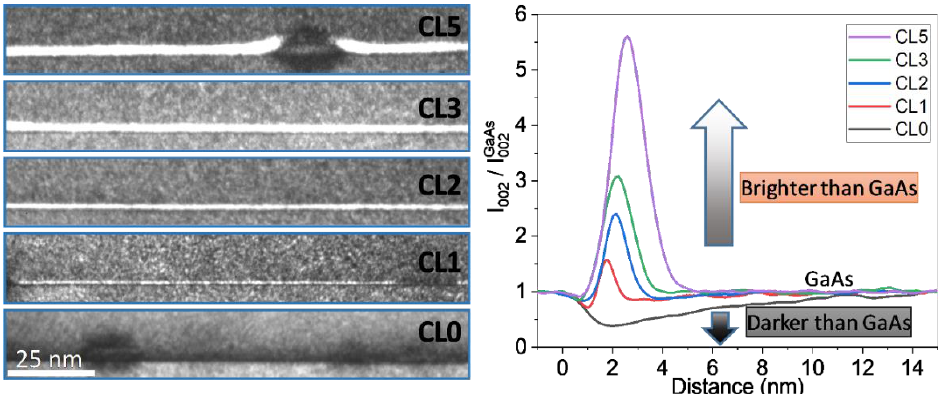
Figure 2. ( Left ) DCTEM g002 DF images of the QD layers with 0, 1, 2, 3, and 5 ML of AlAs CL taken close to the edge of the TEM sample to be near the kinematical conditions (sample thickness below 50 nm). ( Right ) Average intensity profiles along the growth direction of the WL regions normalized to the GaAs intensity.